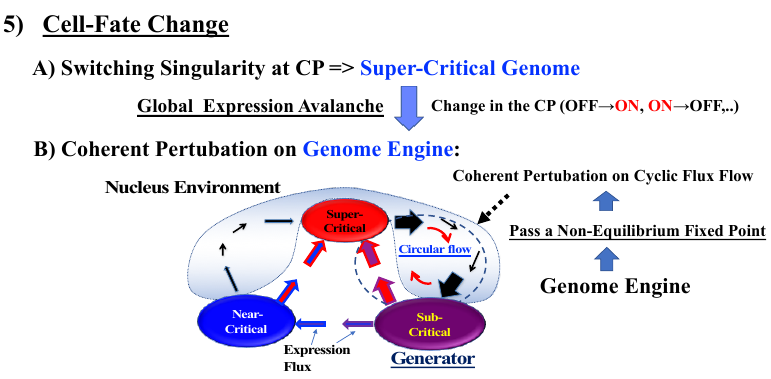
Figure 1. Schematic representation of the genomic mechanism for the cell-fate change. ( 1 – 4 ) The critical point (CP) corresponds to the center of mass (CM) and represents a specific set of critical genes acting as a genome attractor. The CP has activated (ON) and deactivated (OFF) states. ON / OFF switching of the CP state occurs through switching of its singular behaviors, i.e., change in the critical transition of a specific critical gene set. Changes in the state of the CP, such as ON–OFF or OFF–ON switching, guide the genome into a super-critical state; thus, these perturbations can spread over the entire system in a highly cooperative manner. Chromatin remodeling plays a role as the material basis of the self-organized critical (SOC) control of genome expression [10]. ( 5 ) Due to the CP acting as a genome attractor, the self-organization of gene expression develops an autonomous critical-control genomic system (genome engine) through the formation of dominant cyclic flux between local critical states (distinct expression domains according to the degree of nrmsf : Section 4.2.1), where the local sub-critical state is the generator (see details in [7]). Coherent perturbation of the genome engine through changes in the CP (ON to OFF, OFF to ON, etc.) drives the cell-fate change. Before the cell-fate change, the genome (expression) system passes through a non-equilibrium fixed point (stable point of the thermodynamically open system). These five points support the development of a time-evolutional transition theory of biological regulation. Throughout this report, the whole-genome expression vector c ( t j ) at t = t j represents the CM expression vector, in which the center of mass of whole-genome expression, CM( t j ) is subtracted from each expression (Section